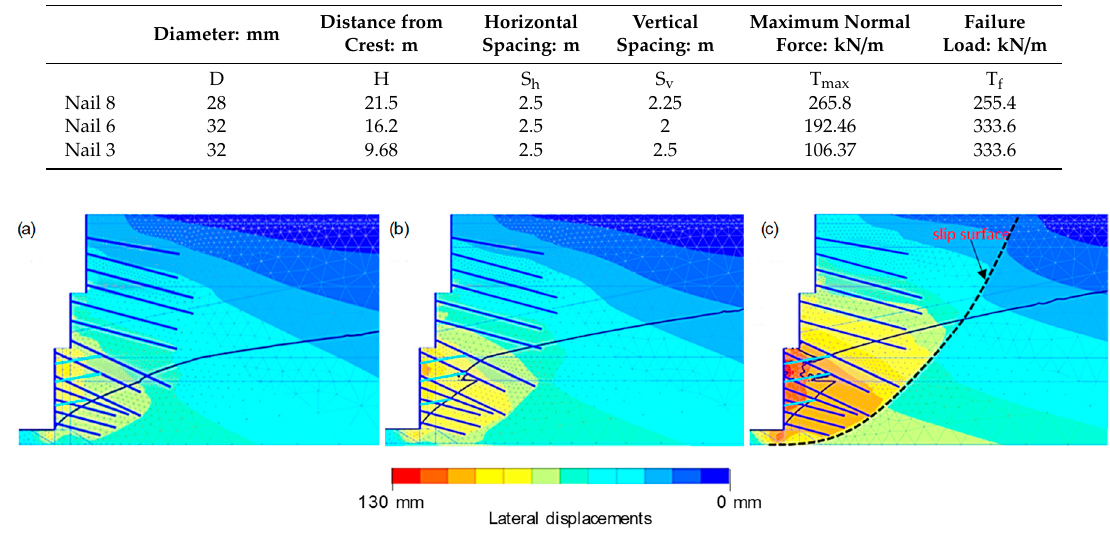
Figure 4. Re-distributed phreatic line following steady state flow and with relevance to drain points;